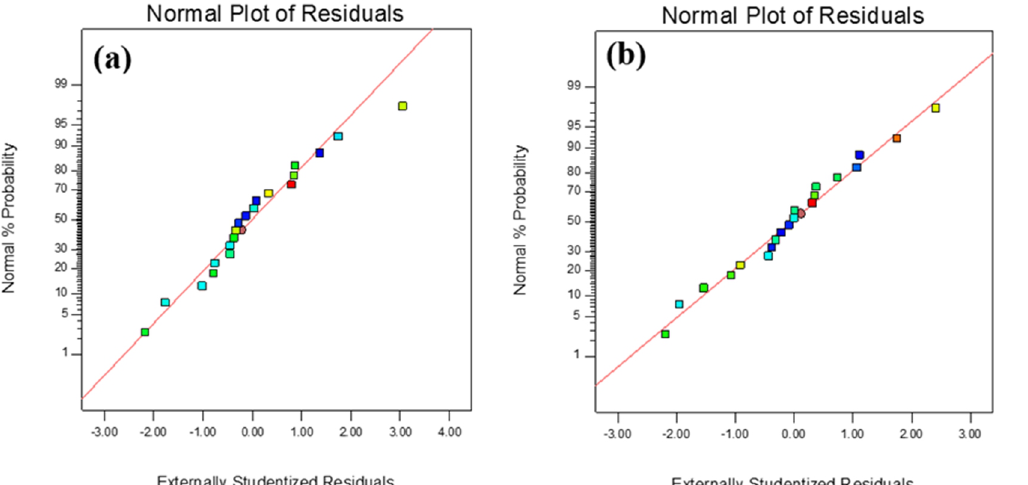
Fig. 2. Diagram of correlations between normal probability percentage and externally standardized residuals for a) Cl − ion removal and b) TDS